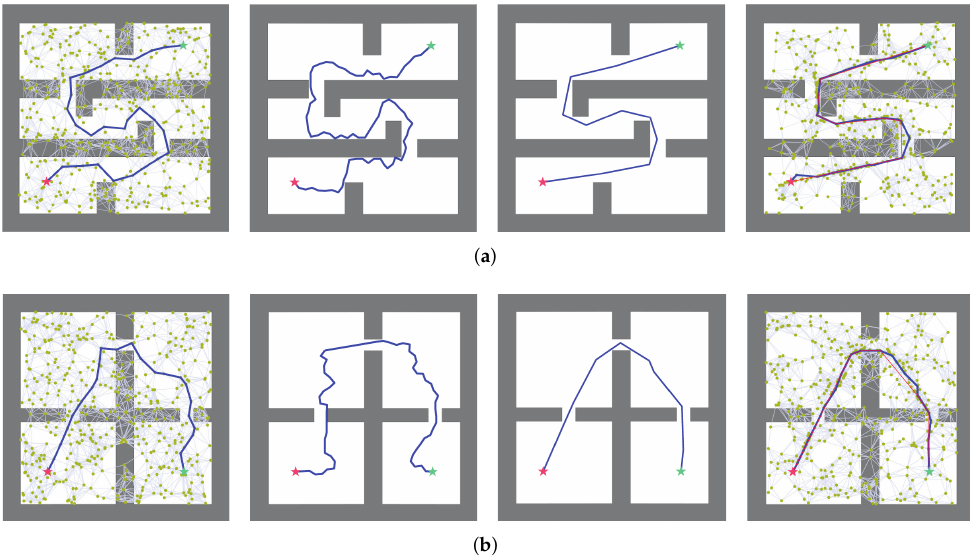
Figure 5. ( a , b ) are two different environments used in the 2D Gridworld experiments. From left to right, the planning results of LazyPRM, RRTConnect, BiRRT*, and LDG are shown. The green and red five-pointed stars represent the start and the goal, respectively; the blue line is the valid path generated by the planner; and the red line is the path of the LDG smoothed by the Rewire function, which can reduce the redundant state of the